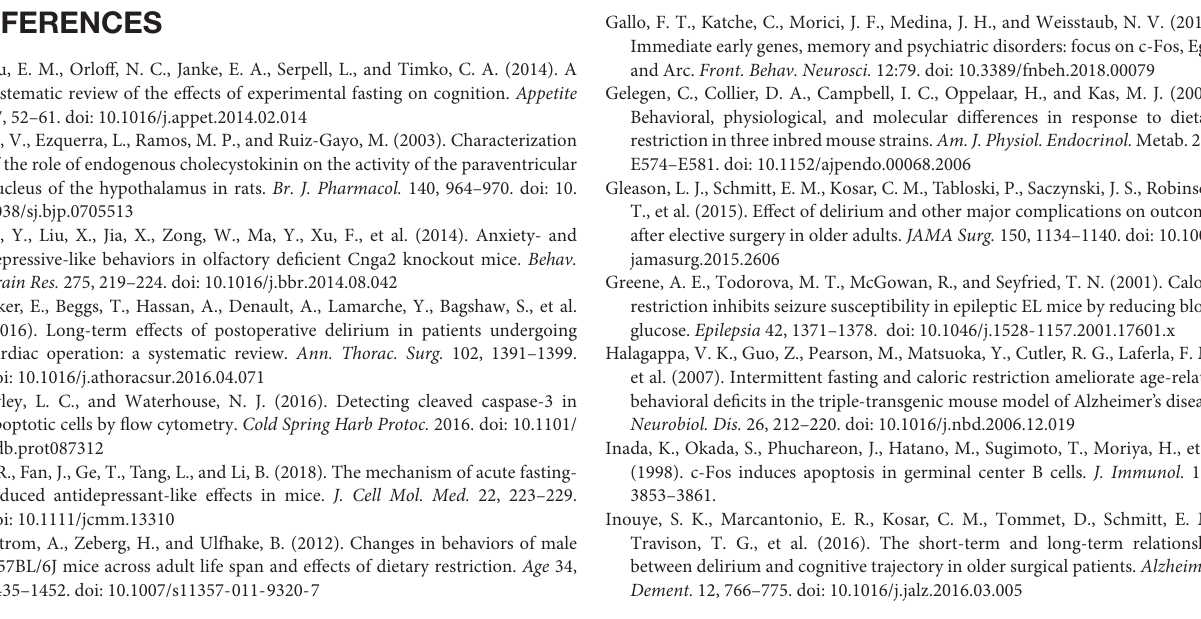
FIGURE S1 | Positive control of immunohistochemistry stained with anti-cleaved caspase-3 antibody. The representative immunohistochemical staining is showing that sleep disturbance -induced cleaved caspase-3 expression distribute in the cortex of mice. The coronal section is located 1.2 ± 0.2 mm anterior from the bregma. The region of interest is outlined with a dash-dot line. Arrows indicate cleaved caspase-3-positive neurons. Scale bars, 100 µ m (left image), 50 µ m (right